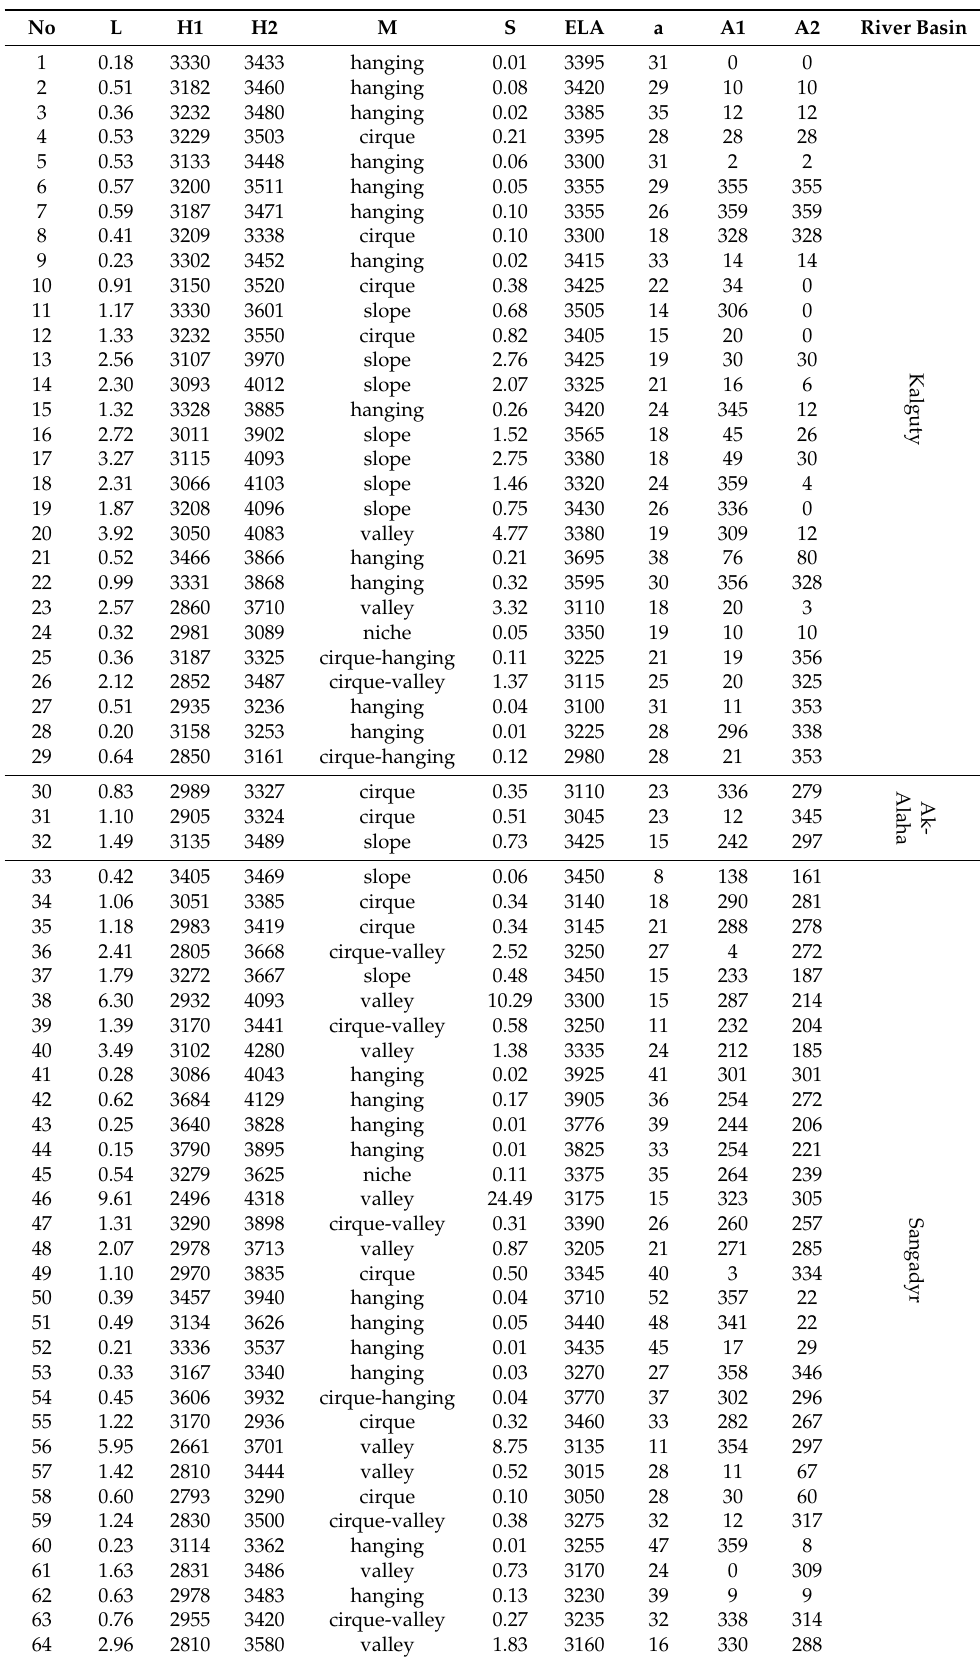
Table 2. Glacier inventory of Tavan Bogd for